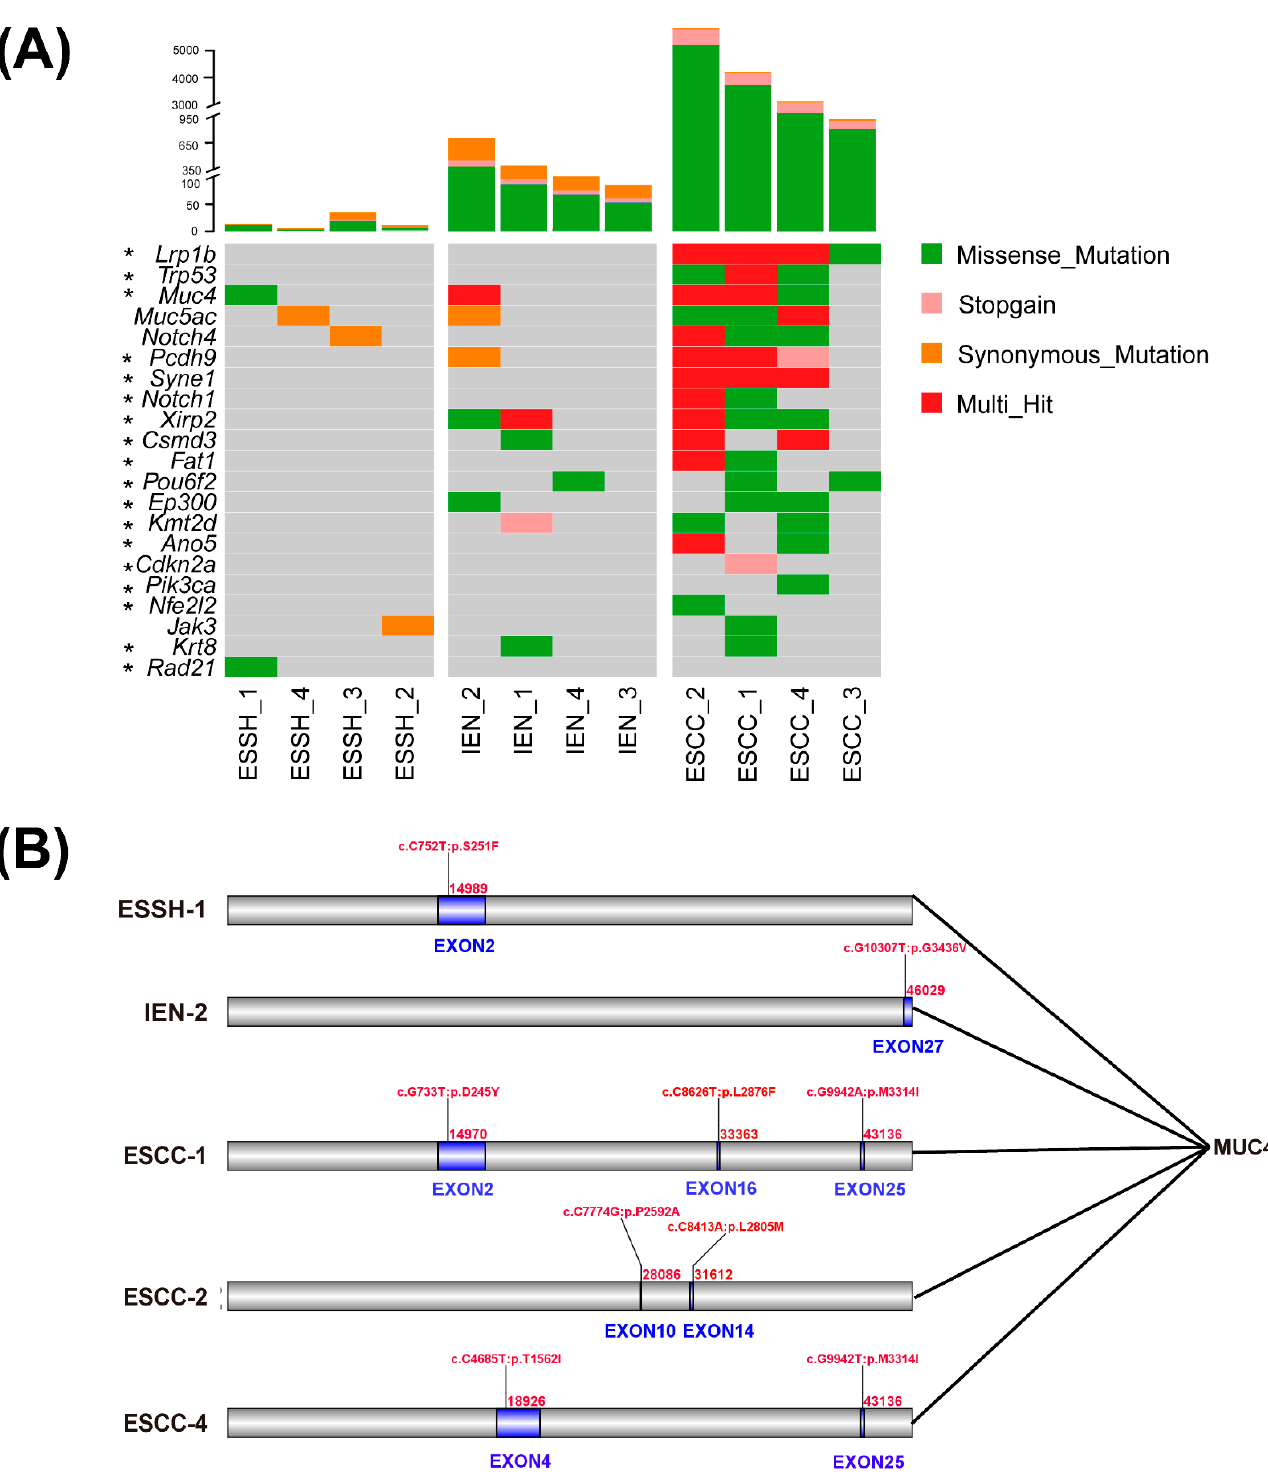
Figure 3. SNVs in different stages of ESCC mice model. ( A ) Top: total number of mutations (synonymous and non-synonymous mutations) in each stage of WES. Bottom: Significantly mutated genes detected by WES and * genes selected from the literature are ranked in the top panel. ( B ) Mutation sites of Muc4 at various pathological stages.